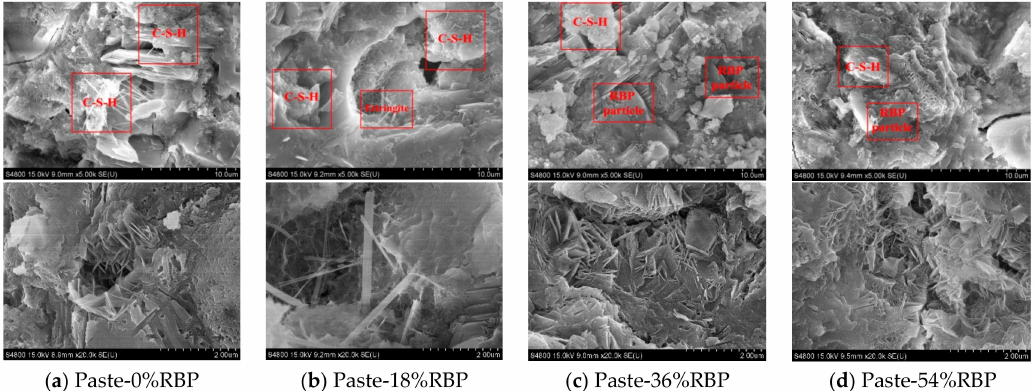
Figure 3. SEM images of paste with various replacements of RBP. ( a ) Paste-0%RBP; ( b ) Paste-18%RBP; ( c ) Paste-36%RBP; ( d )